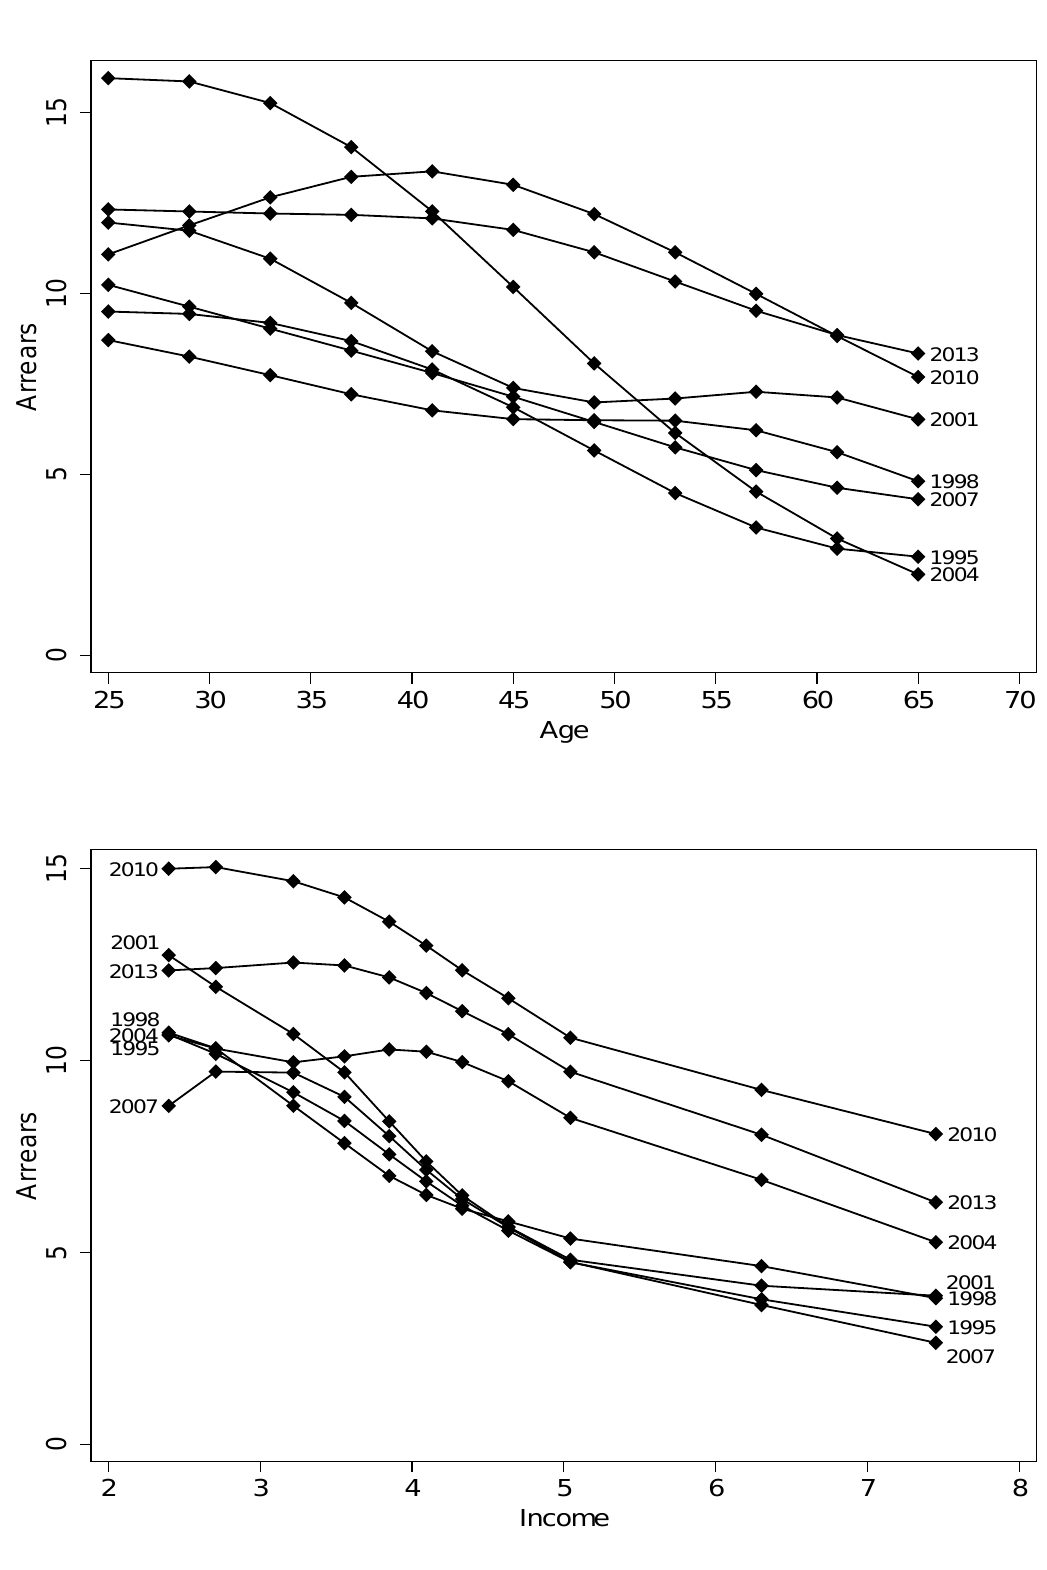
Figure 2. The Effect of Age and Income on Repayment Among All Households.Note: These are kernel estimates of the percentage of households who are in arrears (where non-borrowing households are not in arrears) as age/income changes, holding the other variables fixed at their median value. The estimates of income are at every 10th centile of the income distribution (and additionally the 5th and 95th